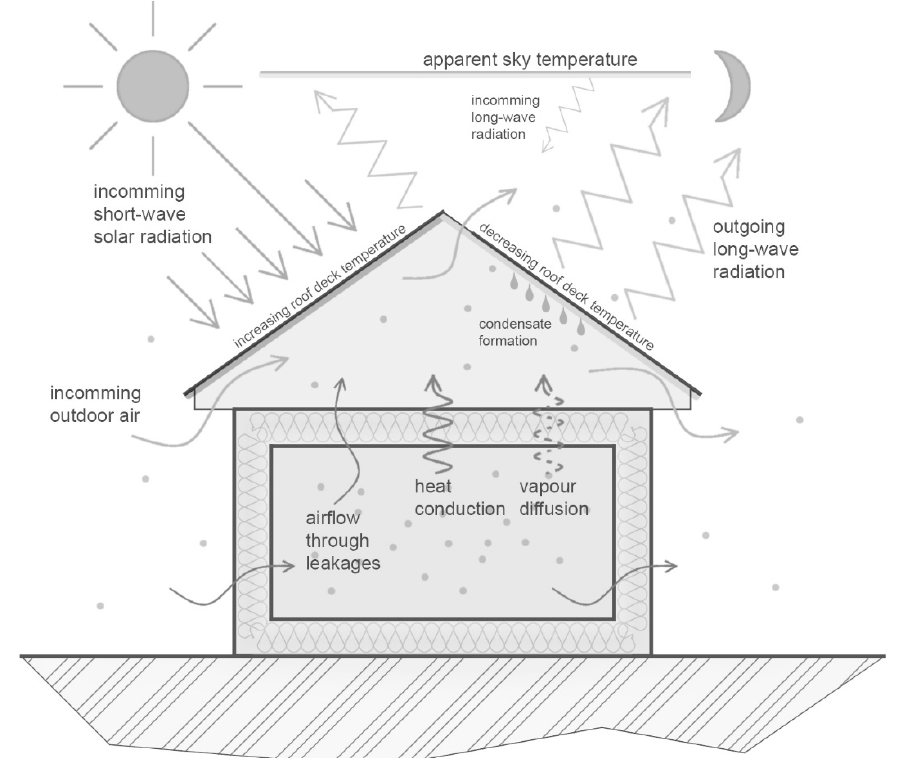
Figure 5. Scheme of heat and moisture transport within a cold attic.